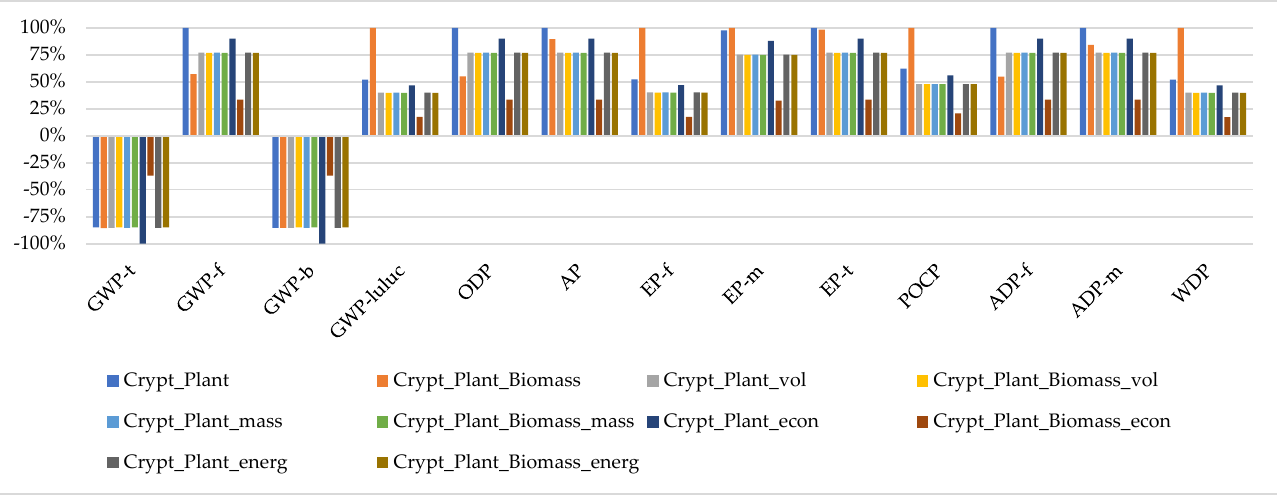
Figure 5. Relative environmental impacts of biomass and roundwood from Crypt_Plant scenario.